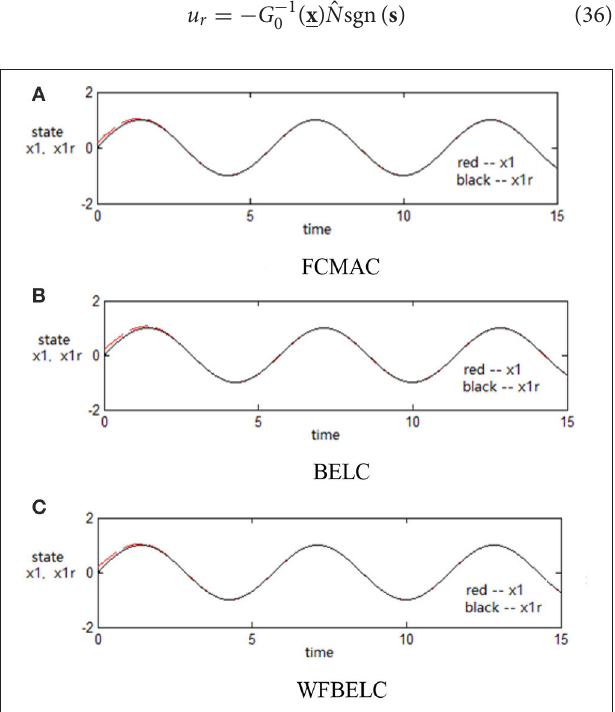
FIGURE 5 | Response tracking curves of state x 1 ( q = 0.3) (A) FCMAC, (B) BELC, and (C) WFBELC.